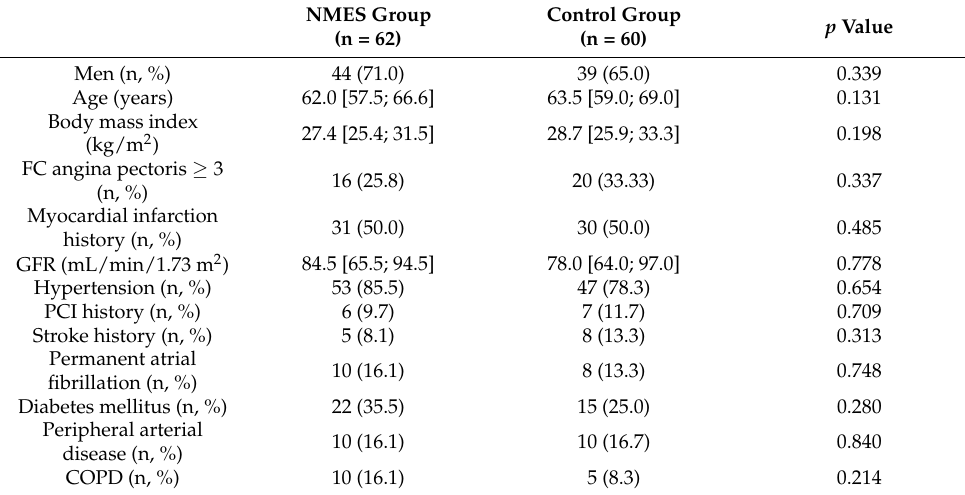
Table 1. Baseline characteristics of patients.